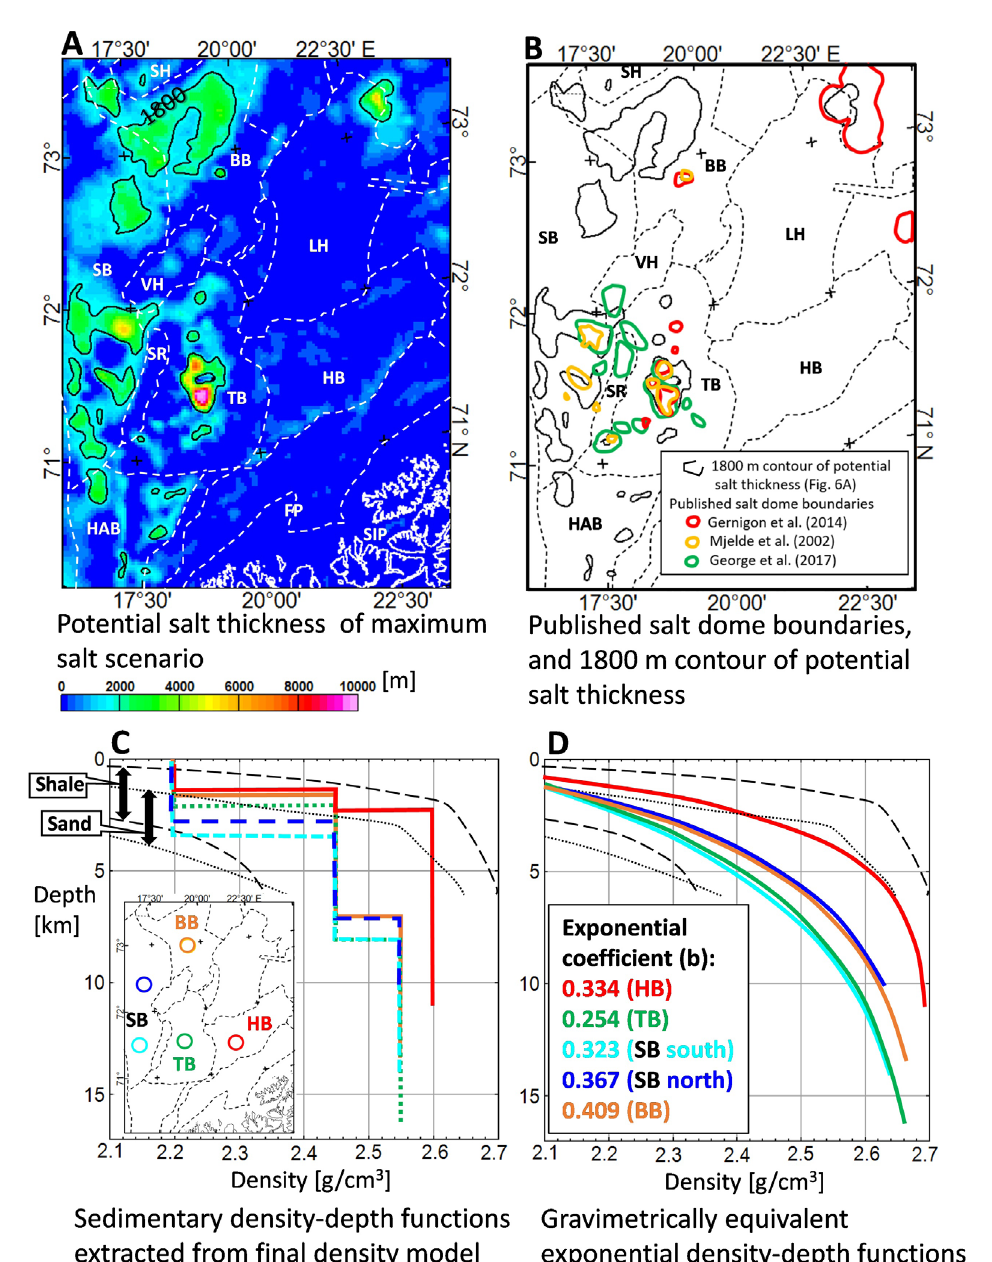
Figure 6. (A) Potential salt thickness in a maximum salt scenario with contour line of 1800 m thickness in black, boundaries of structural elements (white dashed, details in Fig. 1, abbreviations in Fig. 2). (B) Published salt dome boundaries and 1800 m - contour line from Fig. 6A, boundaries of structural elements (black dashed, details in Fig. 1, abbreviations in Fig. 2). (C) Sedimentary density-depth step functions extracted from the final density model (Table 1) with locations in inset and (D) corresponding exponential density-depth functions, for definition of “b” see function: “Dmin + (Dmax - Dmin) * (1 - e - b * depth ); D – density”. Corresponding functions in Fig. 6C and Fig. 6D have the same colour and yield the same gravity anomalies. Density ranges of global compaction curves (see text for details) are superimposed on Fig. 6C, D with black stippled lines–sandstones, black dashed